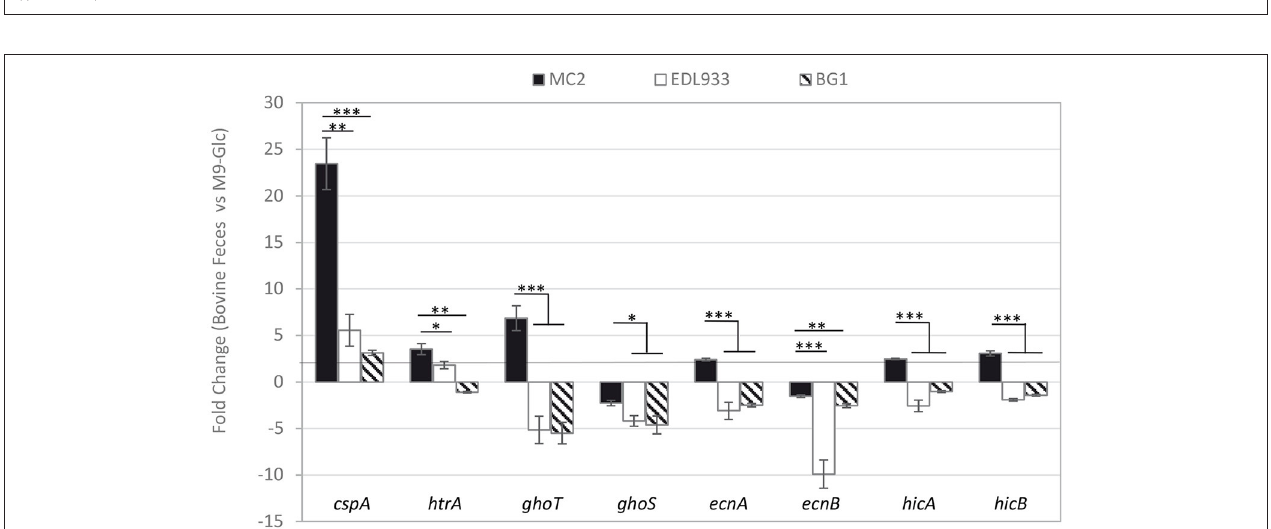
FIGURE 4 | Biofilm formation kinetic of E. coli strains on polystyrene surface when incubated in filtered bovine feces. E. coli strains were incubated up to 3 and 7 days at 39 and 15 ◦ C, respectively. The differences in biofilm formation between the MC2 and BG1 strains were determined by ANOVA with the Tukey post-hoc test (* p < 0.05).